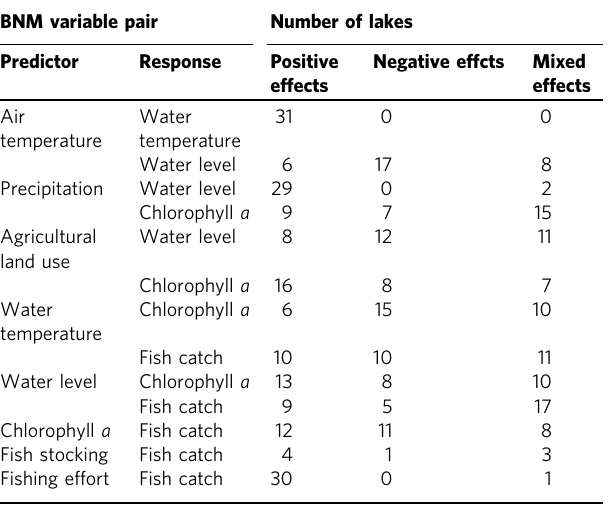
Table 2 Predicted effects between variable pairs in the BNM across